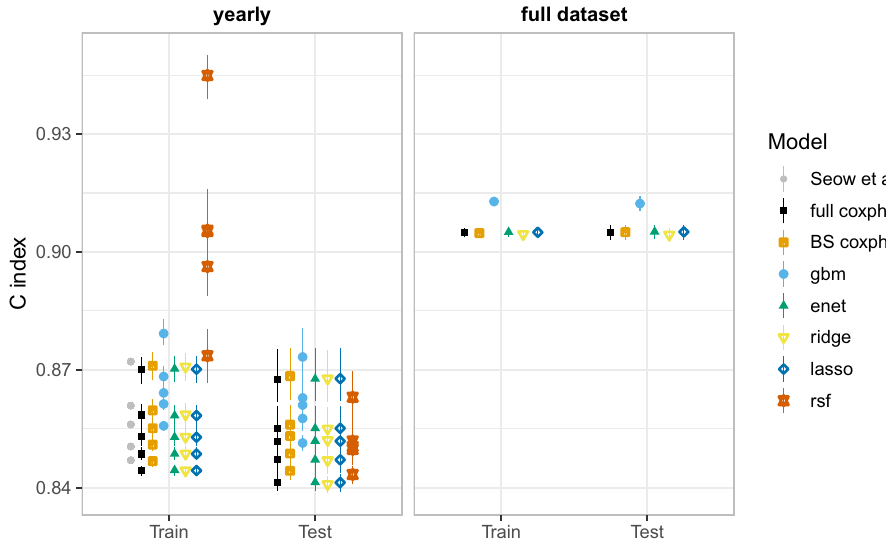
Figure 1. A comparison of Harrell’s concordance scores ( C index) for the yearly-cohort-based time-invariant (yearly) and fully time-varying (full) covariates analysis. Higher values are better. The yearly-cohort-based estimates obtained in Seow et al. 5 were available for training data only. For comparison, we provide both training and test C index scores. Generally, gradient boosting machine slightly performs better than all the other